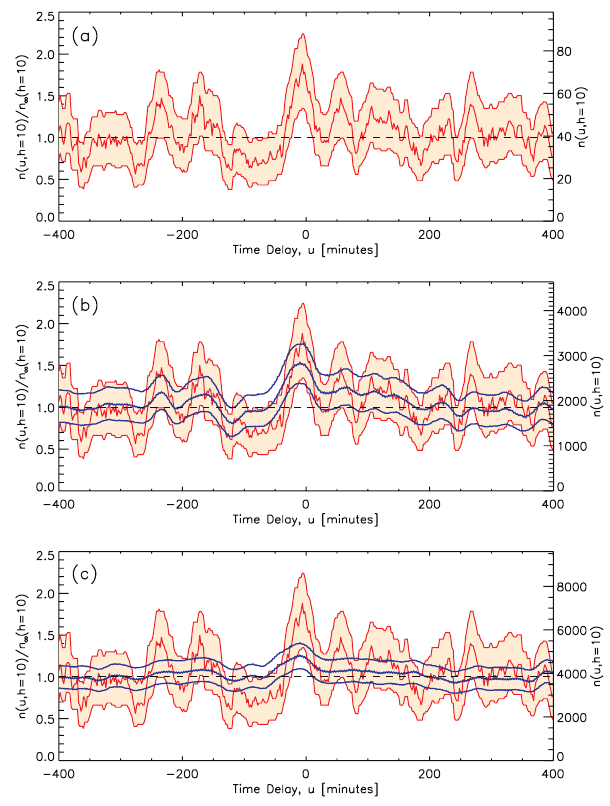
Fig. 6. (a) Association number (thick red line) of candidate external triggers defined by Lyons criteria 1–4 within a window of ± h of the onset time (summed over all observed onsets) as a function of the lag u . The association number n(u,h) is marked on the right-hand axis and normalised to the asymptotic association number on the left hand axis. The thin red lines containing the shaded region mark the 95% confidence limits and the dashed horizontal line indicates the expected association under independence. (b) The association number (thick blue line) of candidate internal triggers defined by Lyons criterion 1 only. The 95% confidence limits are indicated by the upper and lower blue lines and the results from panel (a) are repeated for comparison and scaled according to the left-hand axis. (c) Same as panel (b), but for observed substorms onsets and instances where the > 45 ◦ clock angle criterion described in the text is